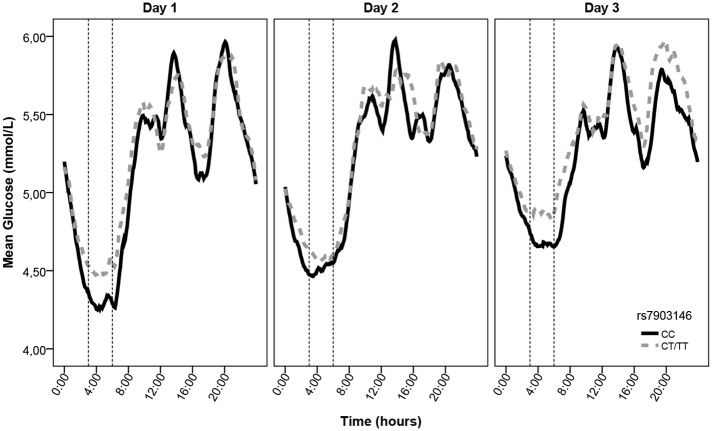
Glucose rhythm over the three days, stratified per genotype group.Mean glucose rhythms during 72 hours for carriers of the protective alleles (black line) and the risk alleles (grey line) of rs7903146 in TCF7L2. The time span between the dotted black lines (3.00–6.00h) represents the nocturnal hours during which people are (on average) fast asleep.